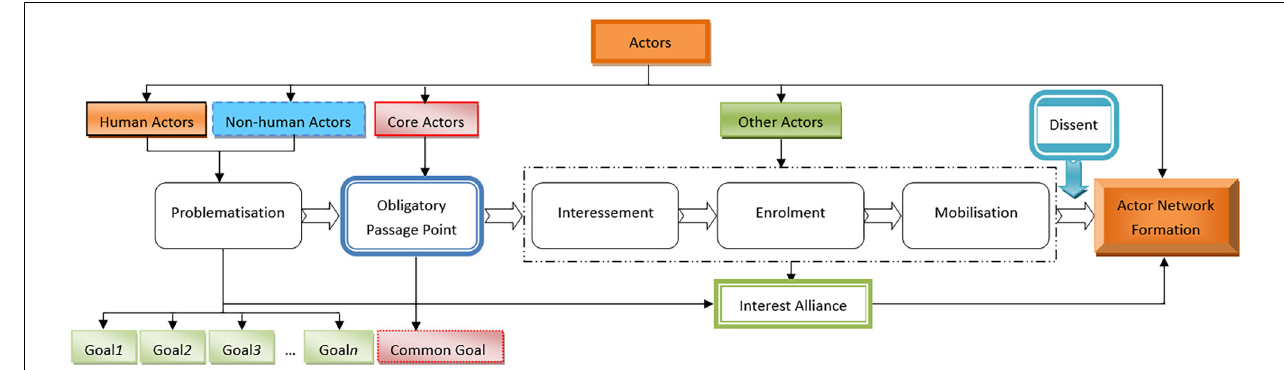
FIGURE 1 | The framework of actor network theory